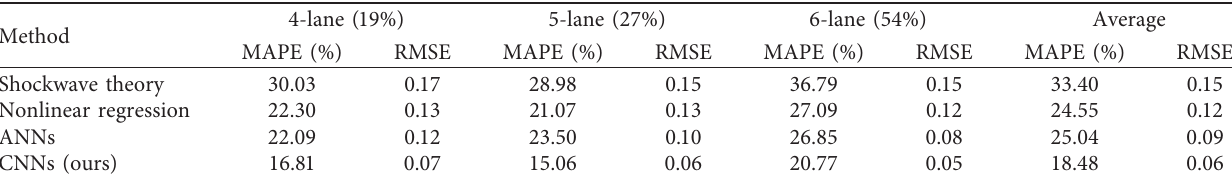
Table 8: Prediction performance comparison of queue length.